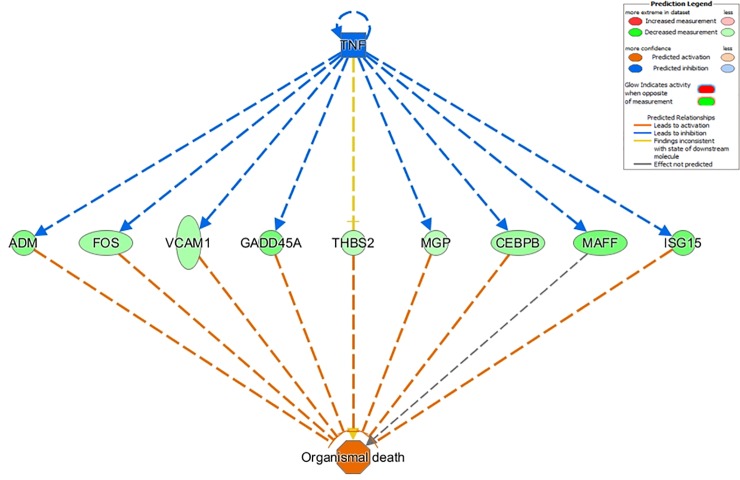
Top-scoring regulator effects network activated in crossbred LBW fetuses.Upper tier: one upstream regulator is predicted to be activated (blue). Middle tier: gene expression changes in response to activation of upstream regulators (green = upregulated in small fetuses). The shapes of the nodes reflect the functional class of each gene product: horizontal ellipse, transcriptional regulator; vertical ellipse, transmembrane receptor; and circle, complex/group/other. Direct interactions are represented by solid lines, while indirect interactions are represented by dashed lines. Orange lines lead to activation. Lower tier: expected phenotypic consequences of gene expression changes based on data in the Ingenuity Knowledge Base (absolute z-score > 2 and p < 0.05). The octagonal symbol defines function.